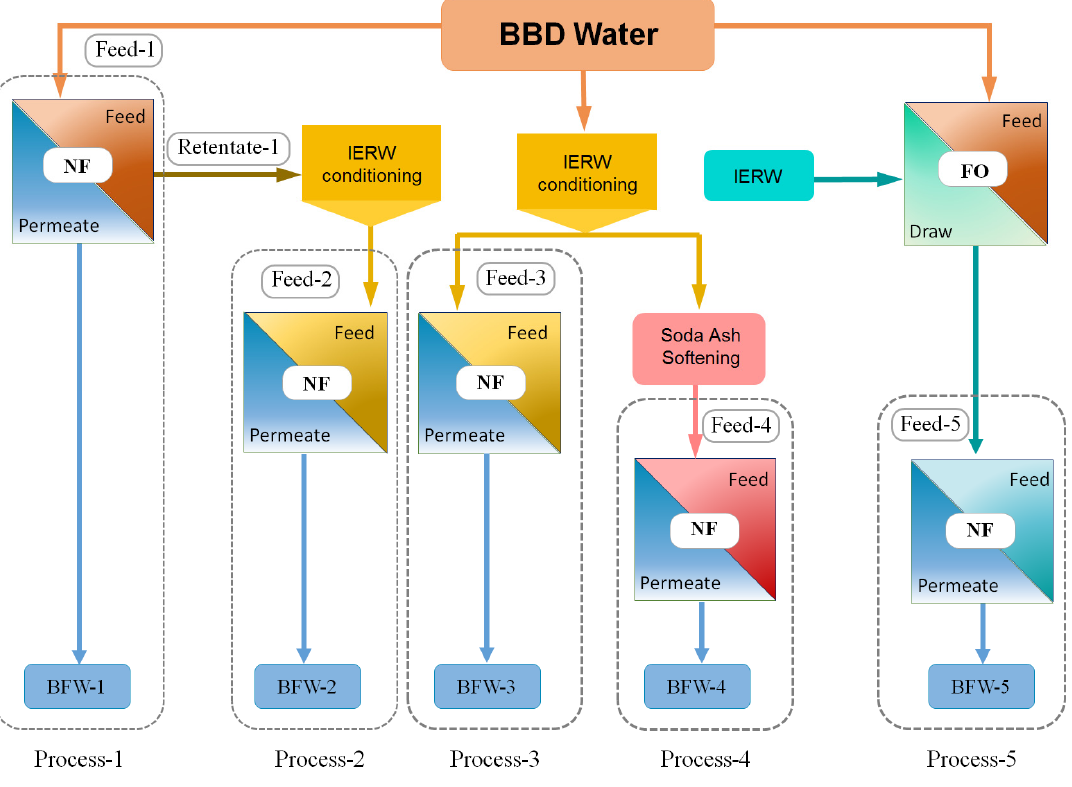
Figure 1. Schematic flow diagram of coagulation-membrane processes for the treatment of steam assisted gravity drainage (SAGD) BBD water. Table 2. Properties of different feed solutions in coagulation-membrane hybrid processes.